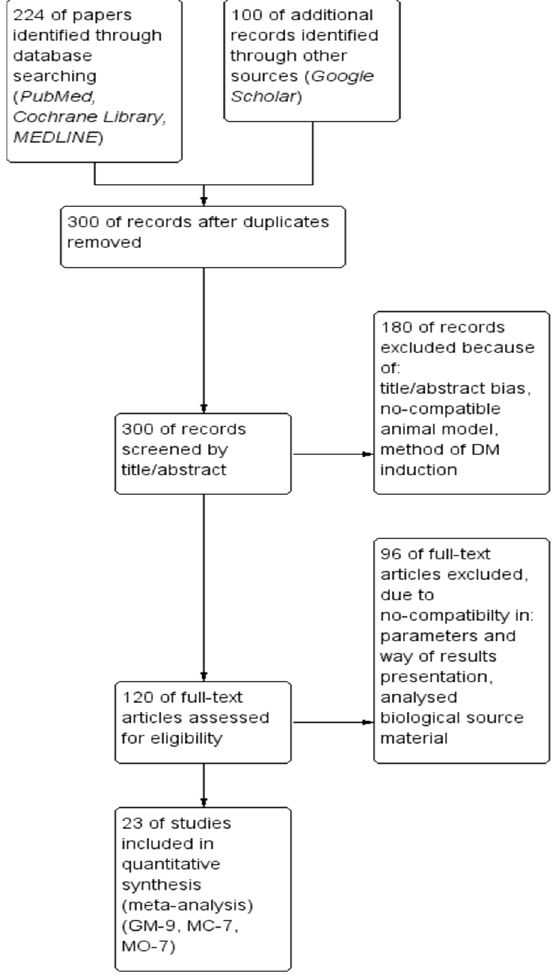
Figure 1. Theflow diagram of the study selection procedure with numerical data about the inclusion and exclusion